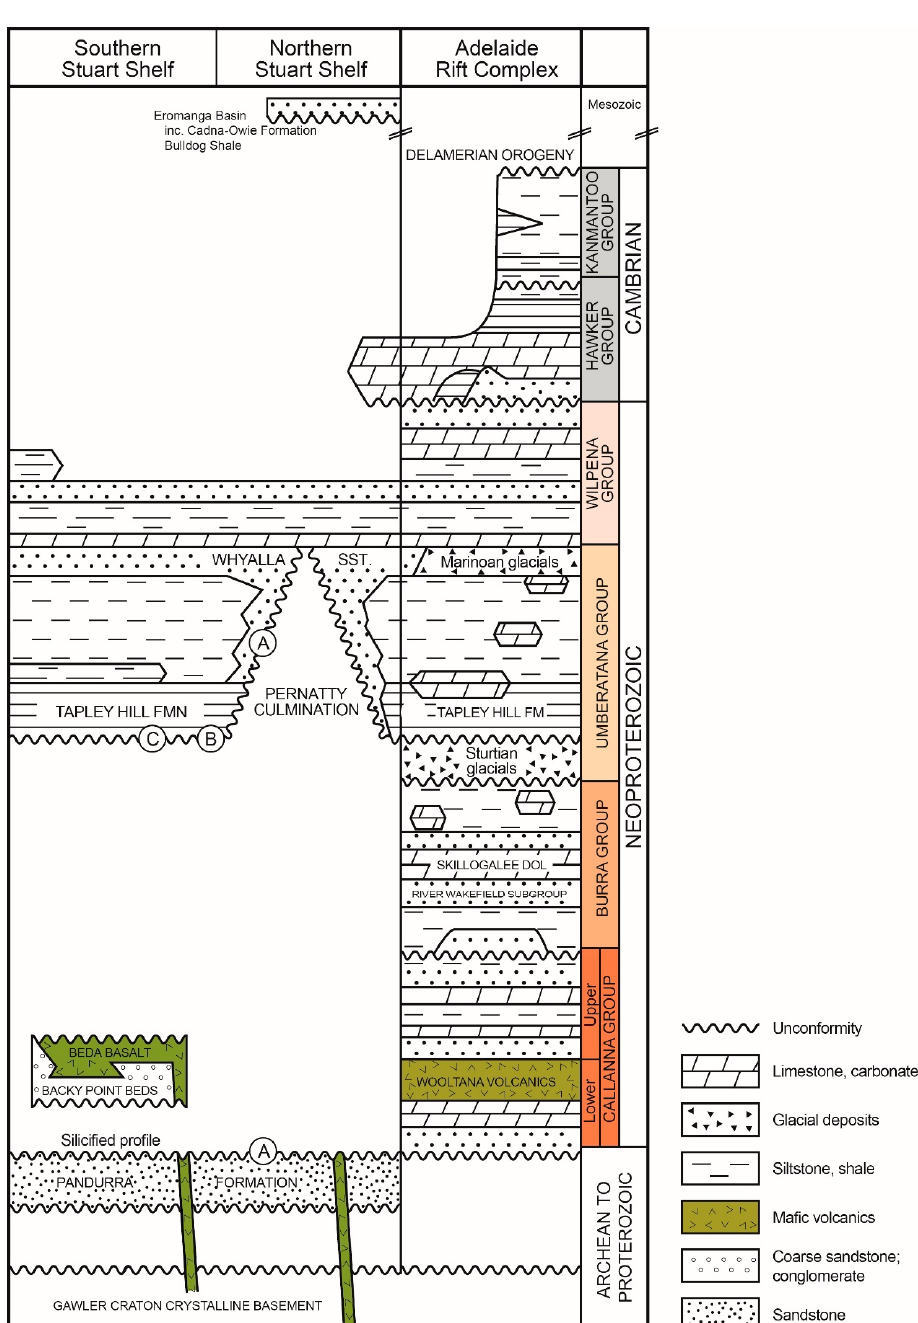
Figure 12. Summary stratigraphic column of cover units of the Stuart Shelf and Adelaide Rift Complex. Modified after [77,144,145]. The Southern Stuart Shelf refers to the region around the Moonta-Wallaroo region, also known as the Spencer Shelf. The Northern Stuart Shelf refers to the region around Olympic Dam. Letters A, B and C refer to the stratigraphic location of unconformity related copper mineralization at the Mount Gunson deposit, including the Cattle Grid (A) and MG14 (B) workings and the Myall Creek (C) deposit. Also indicated is the presence of Mesozoic successions of the Eromanga Basin in the northern portion of the Stuart Shelf region.